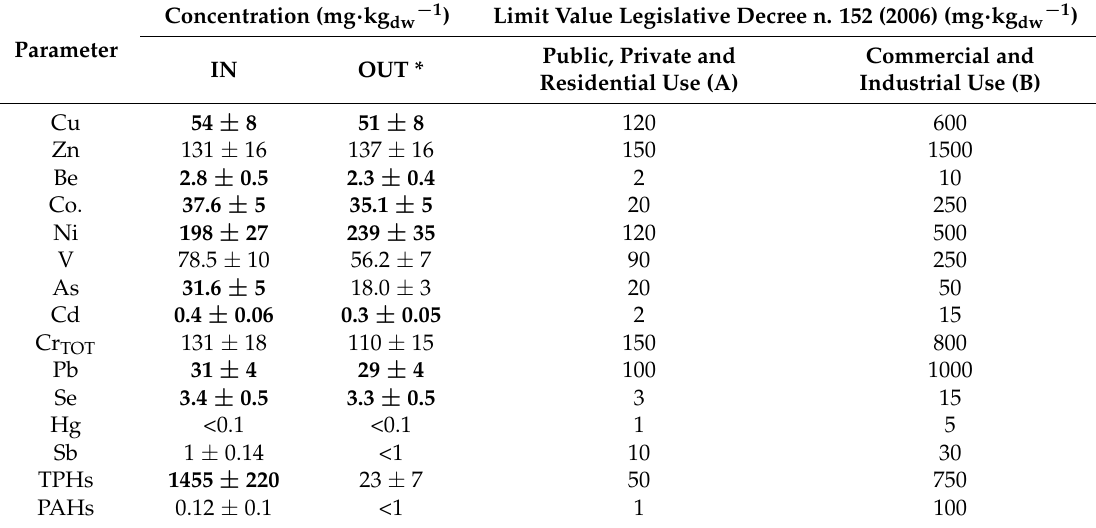
Table 3. Contents of pollutants in soil #1 before and after